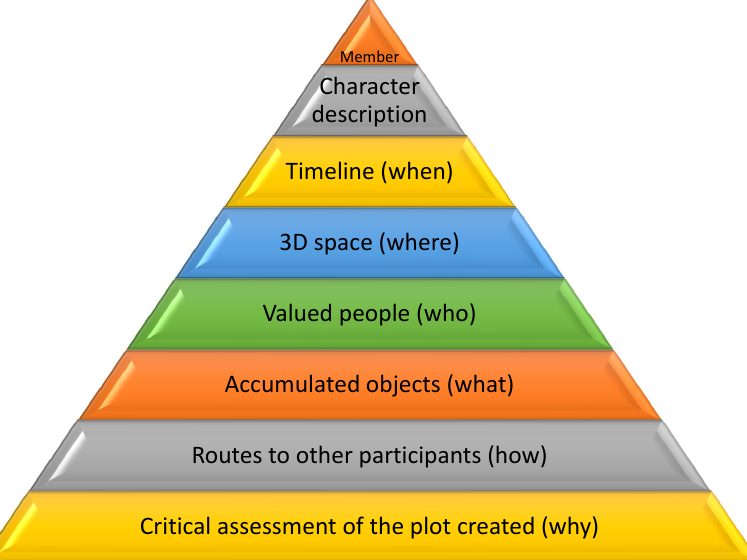
Figure 1. A stylized representation of the levels of the HeNReG process for each member, including the initial description of the participant regarding their research related to health (character descrip- tion), and the six different types of questions (narrative plot) that follow in constructing the landscape of truth. Answers provided to questions lower on the pyramid include a knowledge of the previous answers provided higher on the pyramid, explaining why in this depiction the base is increasingly wider as each type of question is subsequently asked of participants.